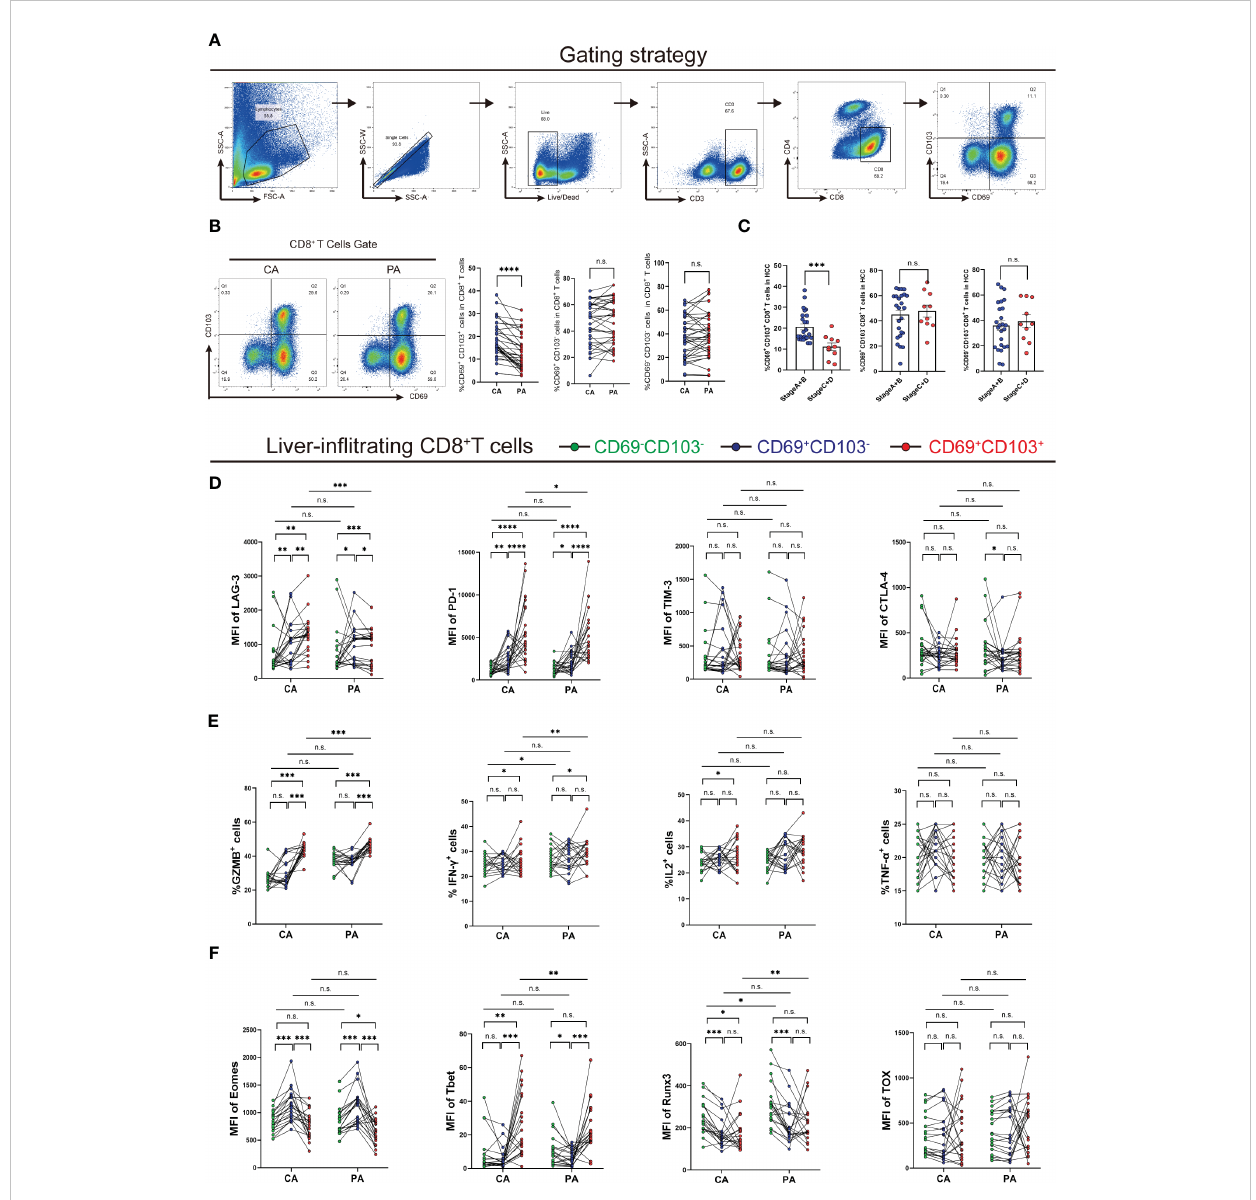
FIGURE 2 Analysis of the frequency, phenotype, and function of intrahepatic CD8 + T RM cells. (A) Gating strategy of intrahepatic CD8 + T RM cells. (B) Proportion of CD8 + T RM cells and other CD8 + T-cell subpopulations in CA and PA in Cohort 1 patients (n = 35, A paired t -test). (C) Ratio of CD8 + T RM cells and other CD8 + T-cell subpopulations in CA of Cohort 1 patients, which were grouped by the BCLC score (n = 35, Student ’ s t -test.). (D) Immune checkpoint expression on CD8 + T RM cells and other CD8 + T-cell subpopulations in CA and PA of HCC patients from Cohort 1 (n = 20, A paired t - test). (E) Cytokine expression in CD8 + T RM cells and other CD8 + T-cell subpopulations in CA and PA of HCC patients from Cohort 1 (n = 20, A paired t -test). (F) Transcription factor expression on CD8 + T RM cells and other CD8 + T-cell subpopulations in CA and PA of HCC patients from Cohort 1 (n = 20, A paired t -test). (B – F) BCLC, Barcelona Clinic Liver Cancer; CA, carcinoma tissue; HCC, hepatocellular carcinoma; MFI, mean fl uorescence intensity; PA, paracancerous tissue. n.s. means not sigini fi cant, * P< 0.05, ** P< 0.01, *** P< 0.001, **** P<